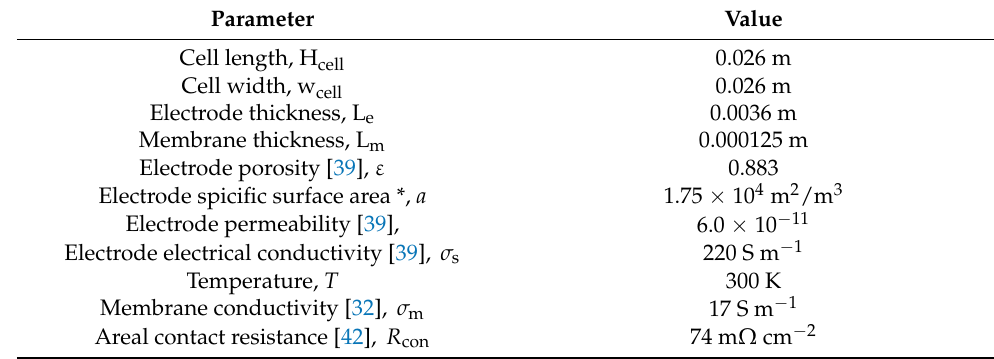
Table 3. Geometric parameters, material properties and operating